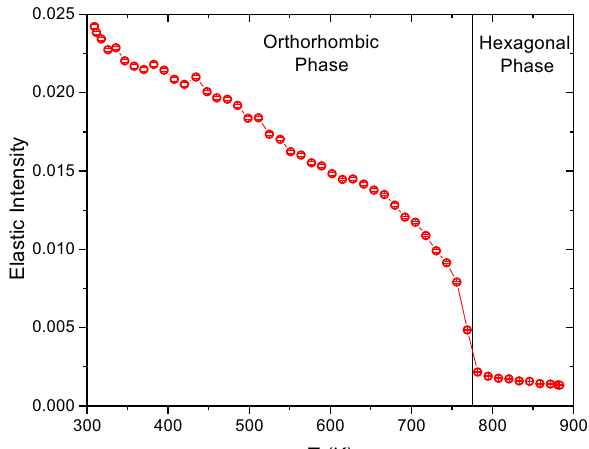
Figure 1. Elastic intensity scan measured at BASIS. The data is averaged over a Q -range of 0.5 – 1.5 Å -1 .